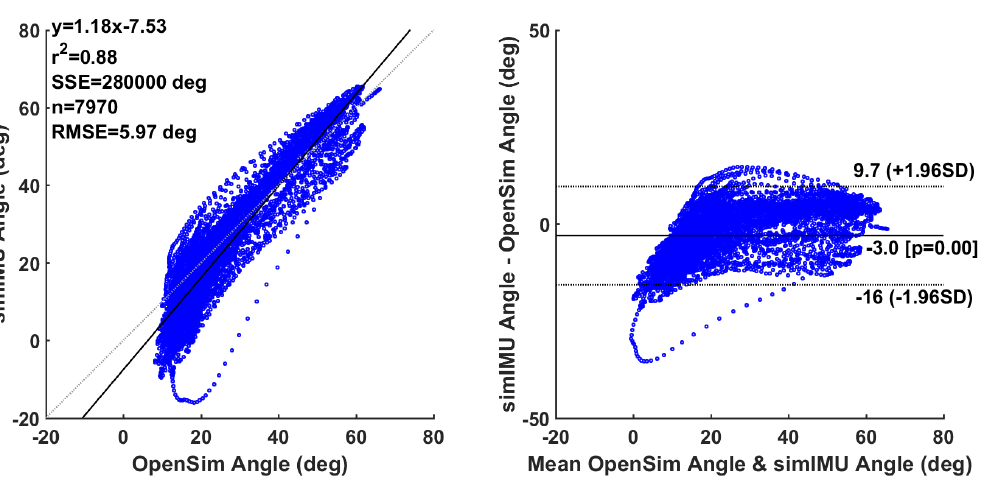
Figure 5. Selected Bland–Altman analyses; linear model given by y ( x ) with associated squared correlation coefficient r 2 , including sum of squared error (SSE) over n data points. Estimated data is the knee angle according to the proposed method on the simulated IMU